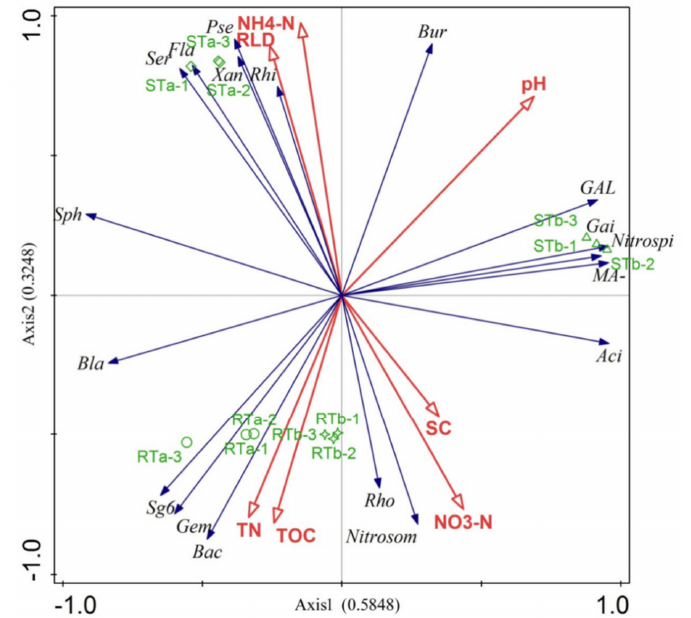
Figure 8. Redundancy Analysis (RDA) of soil properties, root length density and bacterial community structure under different treatments in plow layer.